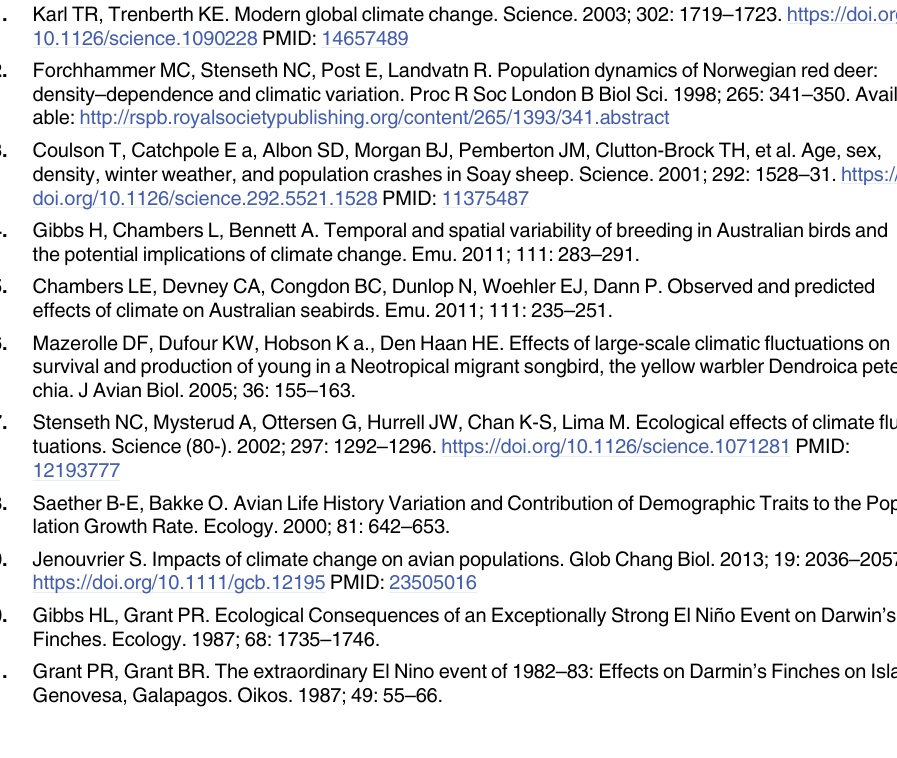
S3 Table. Model selection results for survival analysis of juvenile and adult silvereyes.